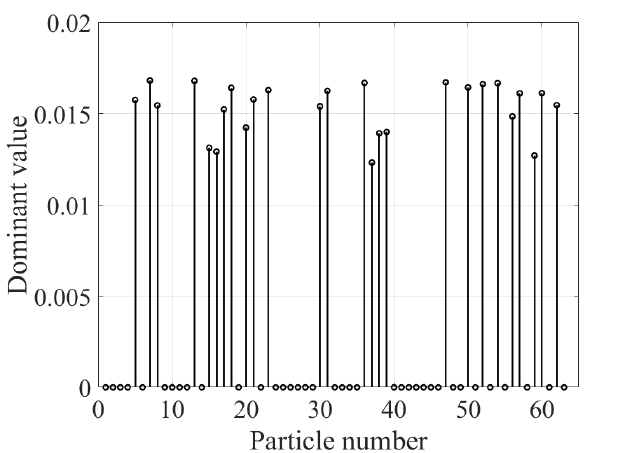
Figure 19. Dominant value of the Pareto-optimal solutions. Table 3. The comparison of parameters of